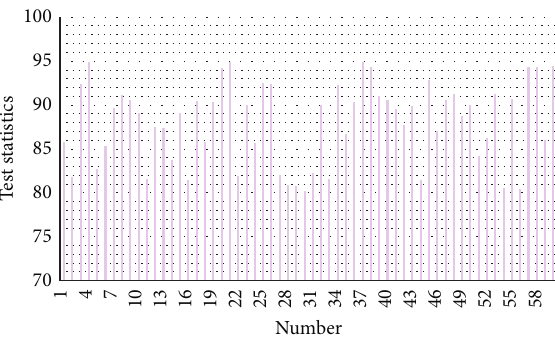
Figure 9: Statistical diagram of the music processing effect of the